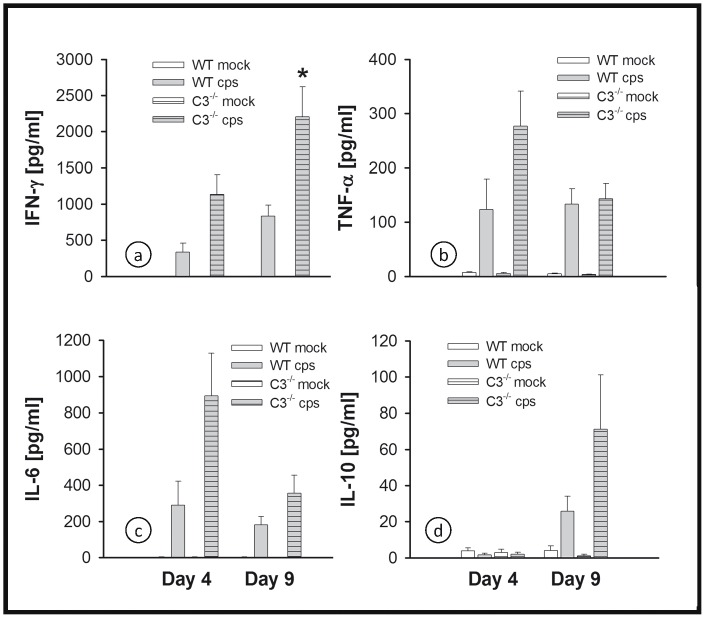
Figure
4. No indication of lack of cytokine response in the absence of a functional complement system. Mice were infected with 104 IFU of C. psittaci DC15 or mock-infected. The cytokines IFN-γ, TNF-α, IL-6 and IL-10 (panel a-d) were determined in the lung homogenate of the animals sacrificed on day 4 or 9. The figure shows data obtained from C. psittaci-infected mice (cps, gray bars), mock-infected mice (white bars), WT mice (open bars) and C3−/− (horizontally hatched bars). * indicates significant (p<0.05) differences between infected knockout as compared to the corresponding infected BL/6J WT mice. Means ± SEM are depicted. * indicates significant (p<0.05) differences between infected knockout mice as compared to the corresponding infected BL/6J WT mice.